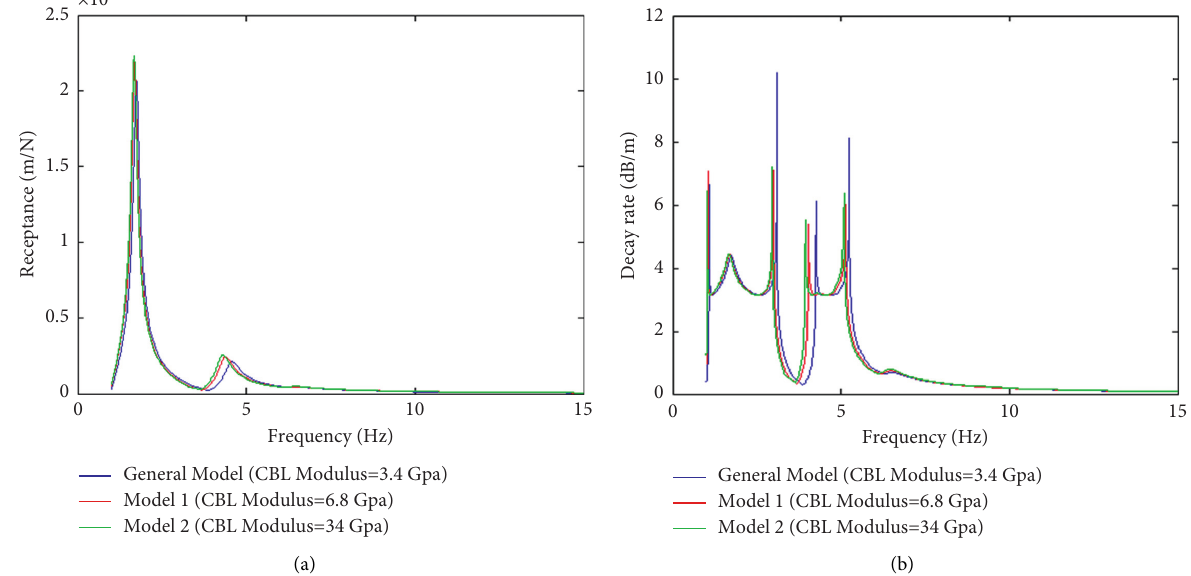
Figure 5: Modulus effect on receptance and decay rate of CBL: (a) effect of thickness on receptance and (b) effect of thickness on the decay rate.